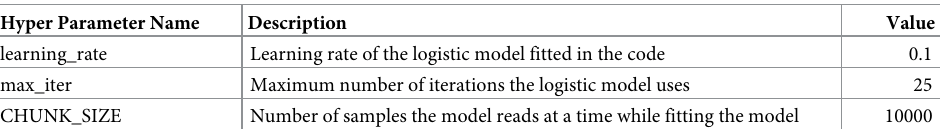
Table 1. Hyper parameter values used in the